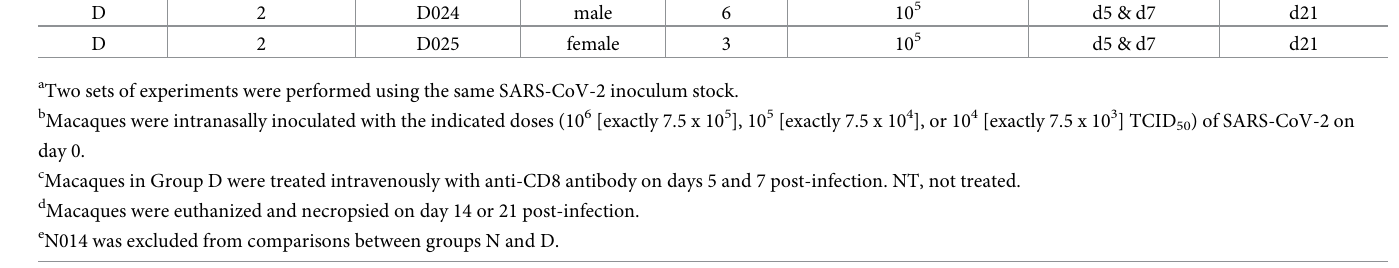
antibody on days 5 and 7, CD8 + T cells were undetectable in peripheral blood on day 7 and thereafter (Fig 3). These three macaques showed comparable levels of viral RNA in nasopha- ryngeal swabs before (day 5) and after (day 7) anti-CD8 antibody treatment compared to the five untreated Group N macaques (Fig 1F). Viral RNA in nasopharyngeal swabs was detectable until day 10 in D025 and day 14 in macaques D023 in D024 after virus inoculation (Fig 1A, 1C and 1D). Viral sgRNAs in nasopharyngeal swabs were detected until day 2 in D023, day 5 in D024, and day 7 in D025 (Fig 2A, 2C and 2D). Collectively, no clear difference in viral RNA levels in swabs was observed for the three anti-CD8 antibody-treated Group D versus the five untreated Group N macaques. We also examined whether virus could be recovered from individual swab samples (Table 2). SARS-CoV-2 was recovered from nasopharyngeal and throat swabs from all eight animals intranasally inoculated with either 10 6 or 10 5 TCID . Virus was recovered for 2–12 50 days in anti-CD8 antibody-untreated macaques (until day 2 in N021, day 5 in N013 and N022, day 7 in N011, and day 12 in N012) and for 2–7 days in anti-CD8 antibody-treated macaques (until day 2 in D024 and day 7 in D023 and D025). There was no indication of enhanced virus recovery after CD8 cell depletion.